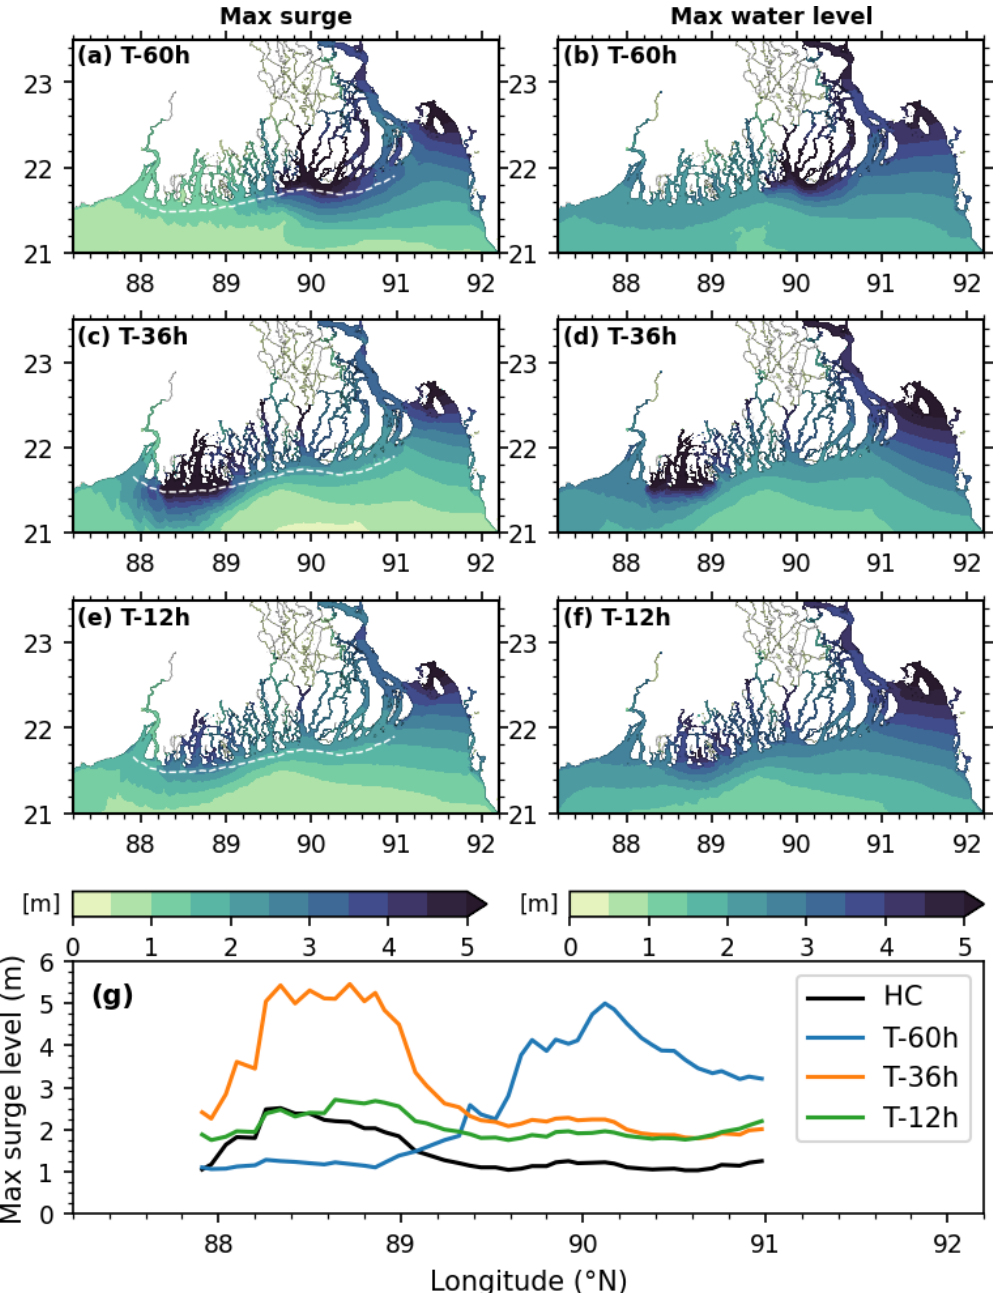
Figure 8. Maximum surge (a, c, e) and elevation (b, d, f) evolution for forecast initiated at (a–b) T − 60h (18 May 2020 00:00Z), (c–d) T − 36h (19 May 2020 00:00Z), and (e–f) T − 12 (20 May 2020 00:00Z) hours before landfall. (g) Comparison of maximum surge level extracted along the section shown by the white line in (a) , (c) , and (e) . Hindcast results (HC) is extracted along the same line shown in Fig. 6b.